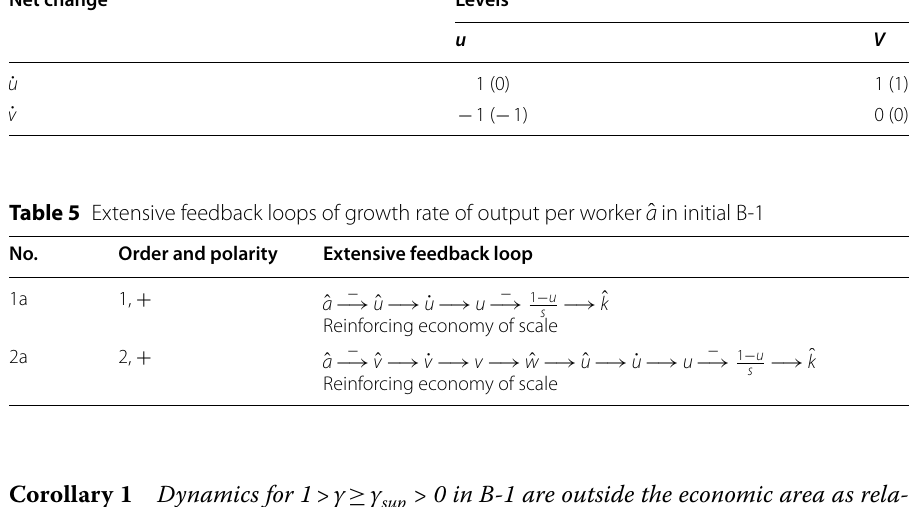
in B-1 and at neutrally stable E p